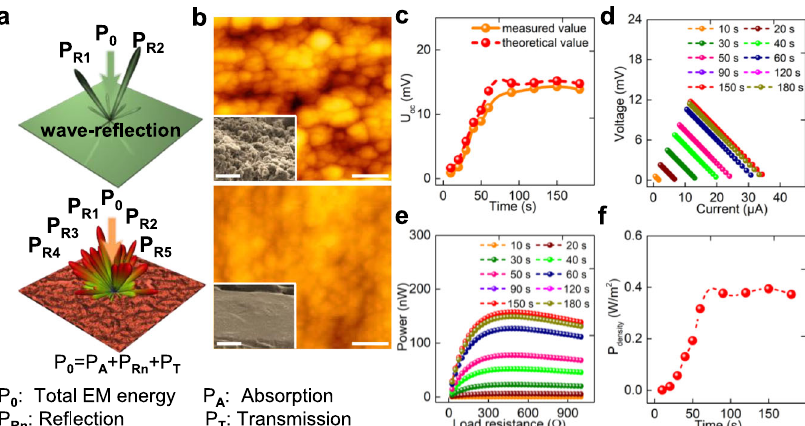
Fig. 5 The as-prepared EM wave-electricity harvester. a Schematic illustration of EM wave re fl ection on the PL and Sn@C interlayer; b atomic force microscope (AFM) images of Sn@C before and after depositing PL layer (scale bar 50 μ m); the inset showing the corresponding surface condition observed by FESEM (scale bar 10 μ m). c Time-dependent of open-circuit voltage, d output voltage-current, e output power and f power density for the EM wave-electricity harvester. Note that the changed voltage and current could be recorded by tuning the load resistance from 0~1000 Ω